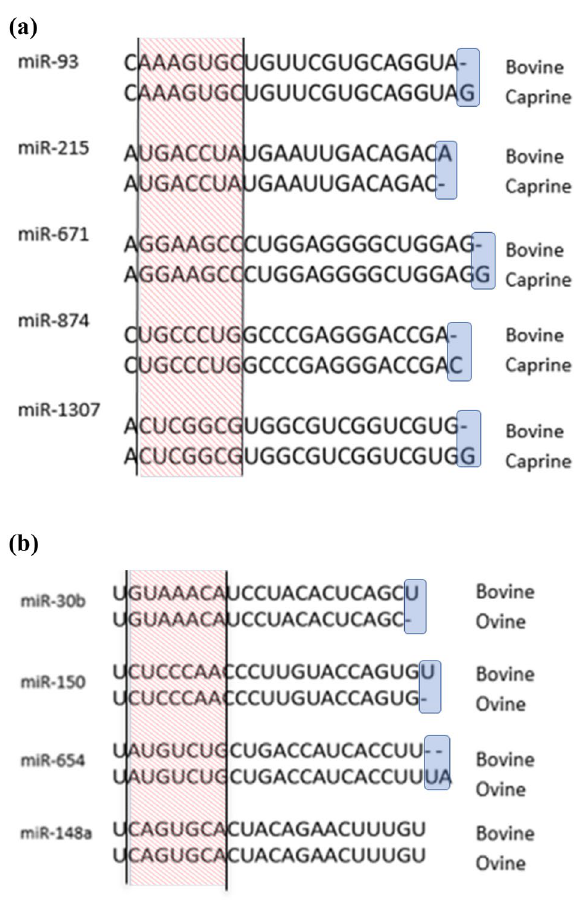
Figure 2. ( a ) Nucleotidic sequence of the five microRNAs presenting genetic variants in the precursor of both bovine and caprine species. The differences are located at the end of each microRNA. ( b ) Nucleotidic sequence of the three microRNAs presenting genetic variants in the precursor of both bovine and ovine species. The seed regions of the microRNAs are indicated between the black traits, in the red stripes. The nucleotidic changes are highlighted in blue squares.